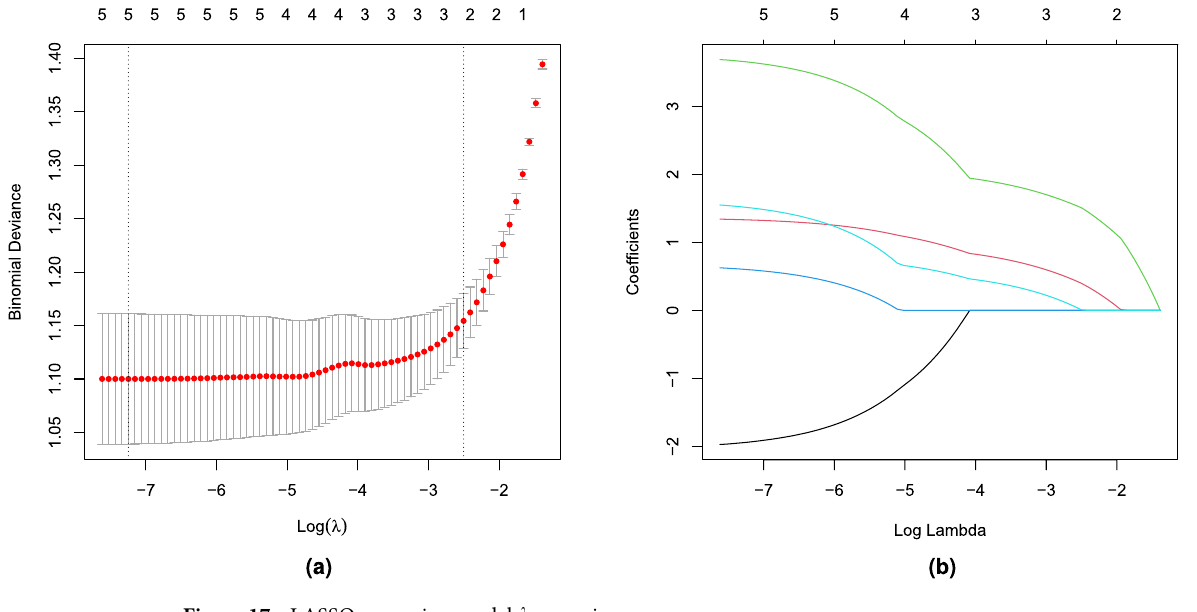
Figure 17. LASSO regression model (cid:31)